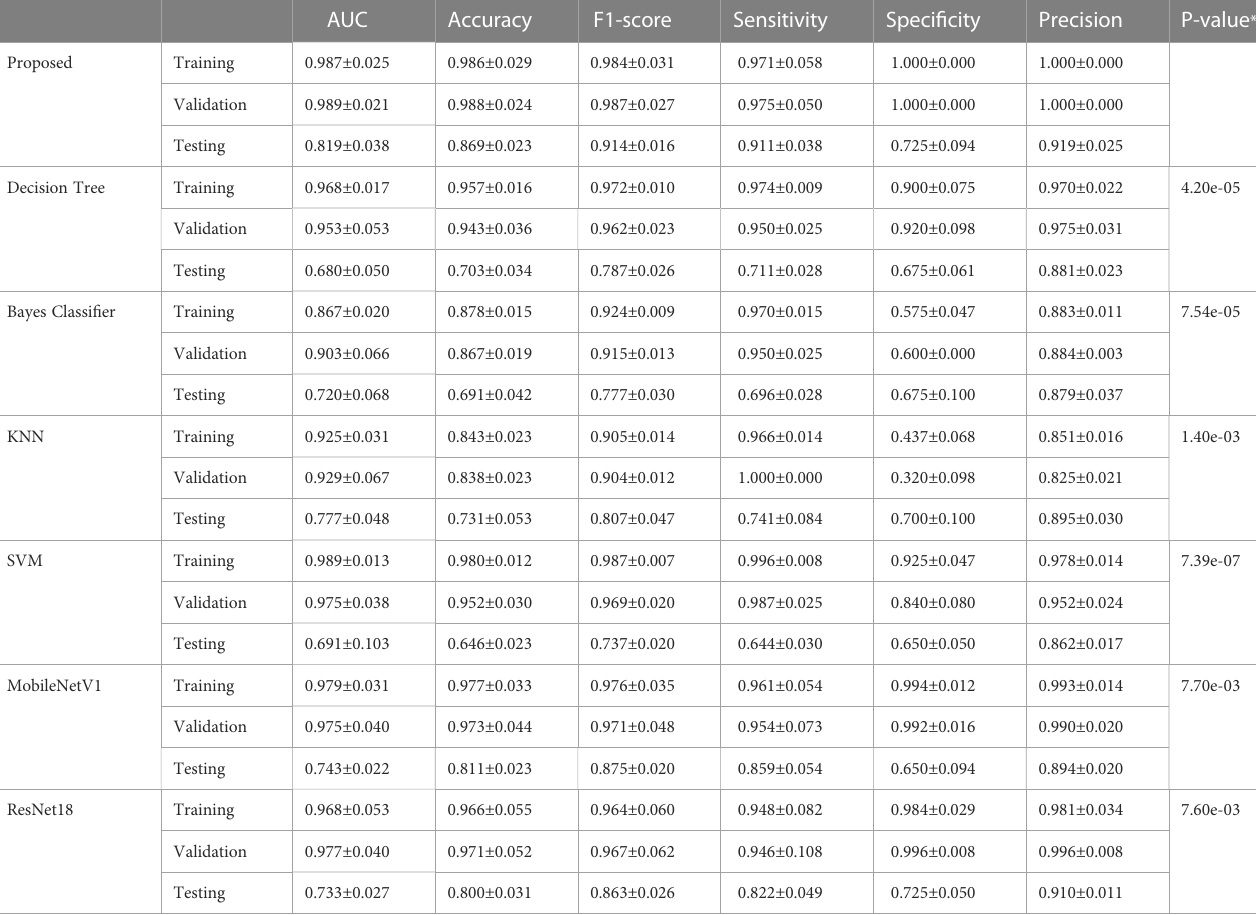
TABLE 2 Comparison results of the proposed method and other competing methods.